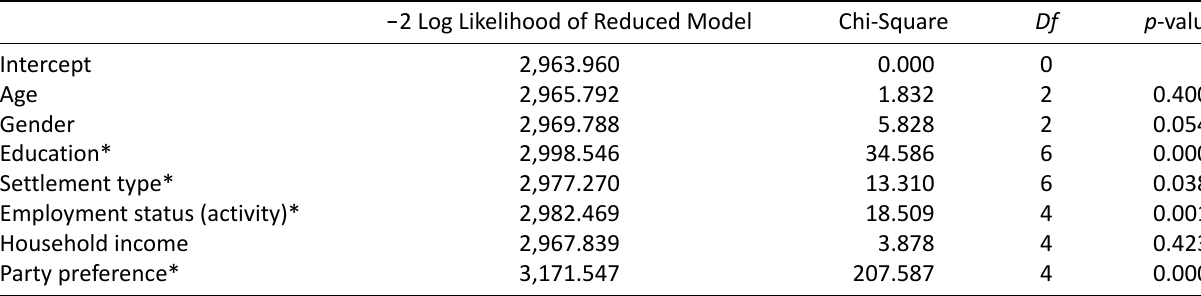
Table 1. Effect of the